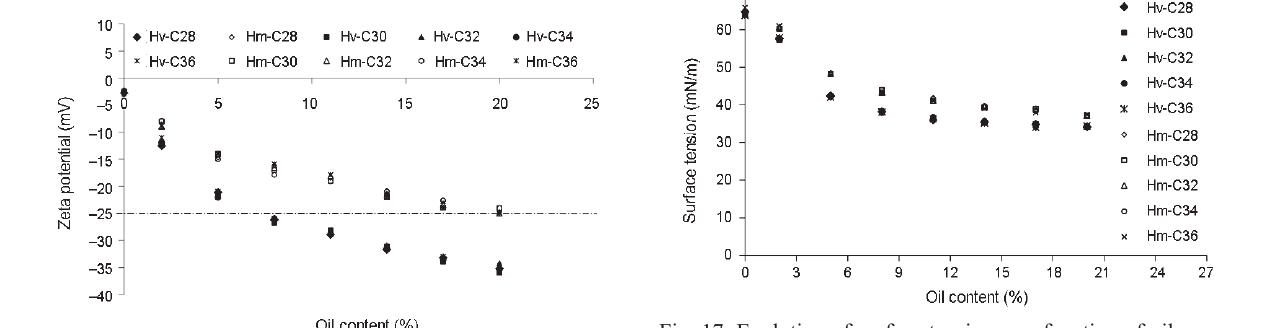
Fig. 17. Evolution of surface tension as a function of oil